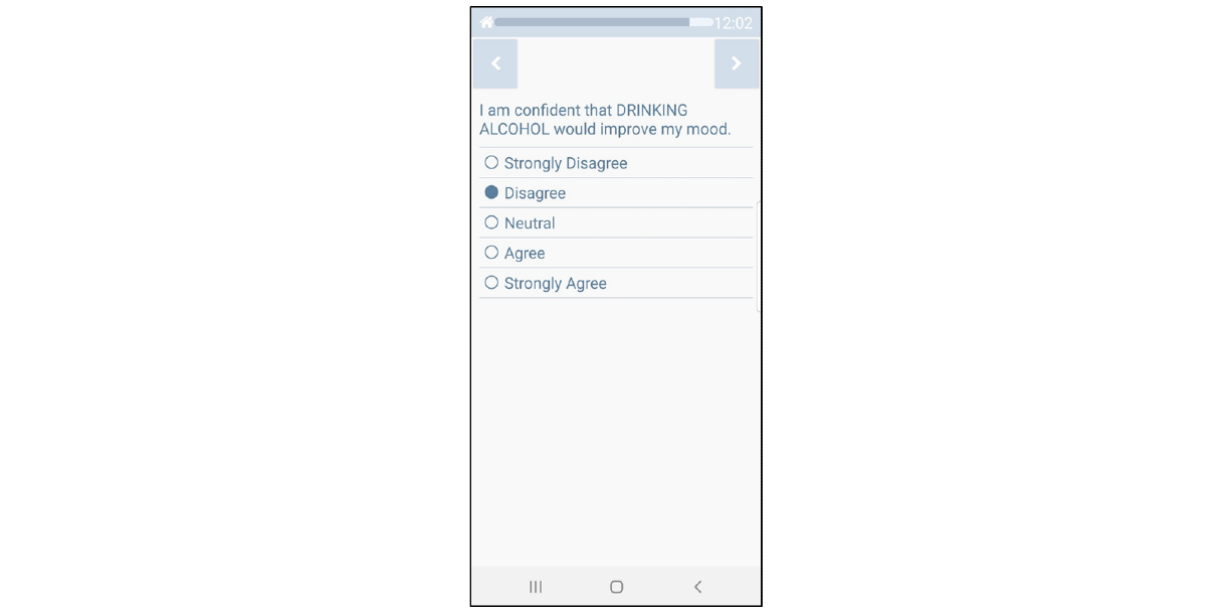
Figure 2. Smart-T alcohol example